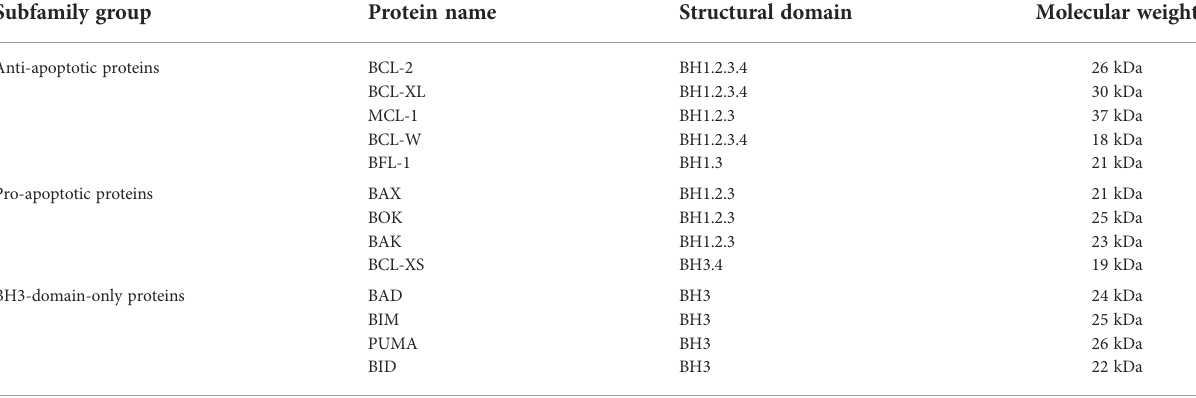
TABLE 1 Subfamily groups, domains, and relative molecular weights of the BCL-2 family proteins. Subfamily